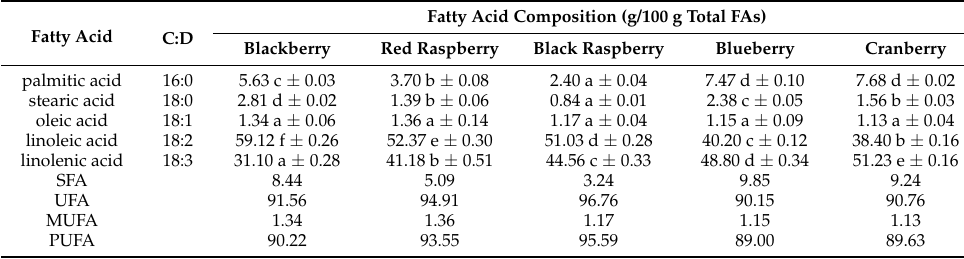
Table 2. The fatty acid compositions in the five berry seed oils.